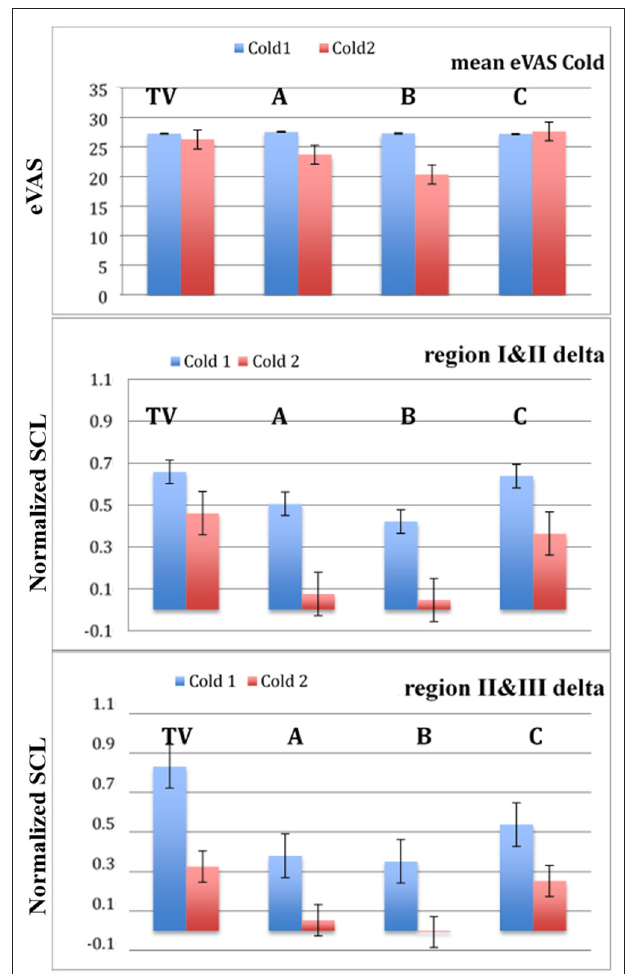
FIGURE 8 | The mean values of eVAS alone do not successfully discriminate both effective analgesics. The deltas comparing normalized SCL values across adjacent regions are more discriminatory. Cold 1 = blue, Cold2 = red, n = 23 participants. Bars are